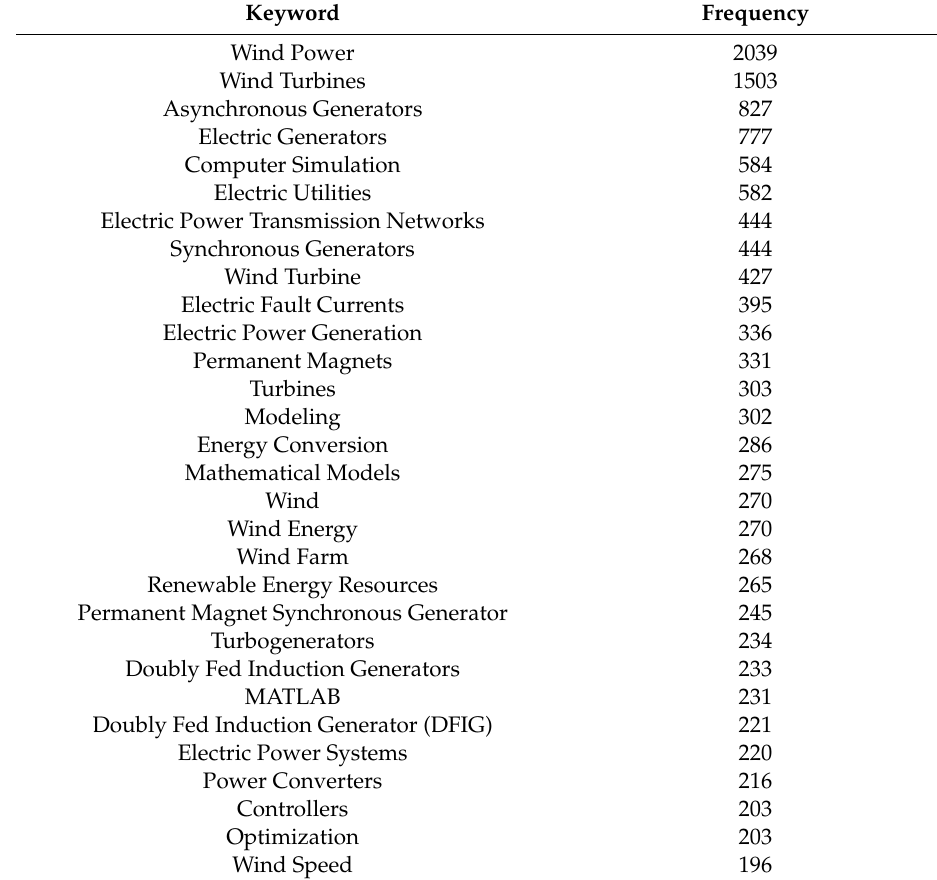
Table 3. Keywords and their frequency in wind turbine